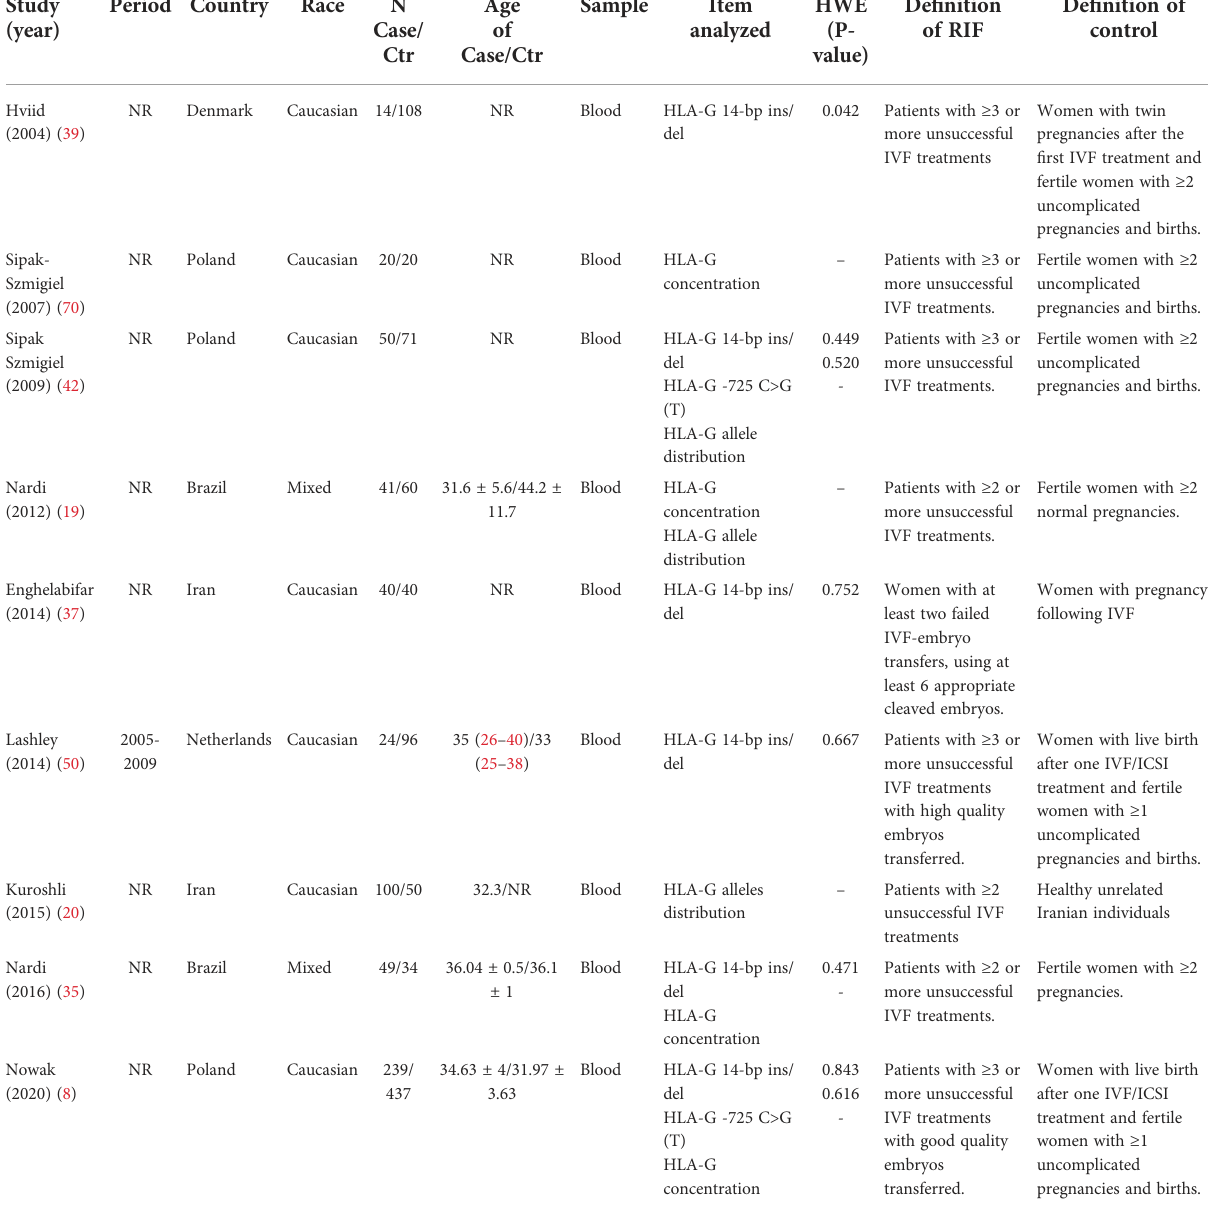
TABLE 2 Characteristics of studies included in the meta-analysis that reported the associations between HLA-G polymorphisms or sHLA-G expressions with RIF.